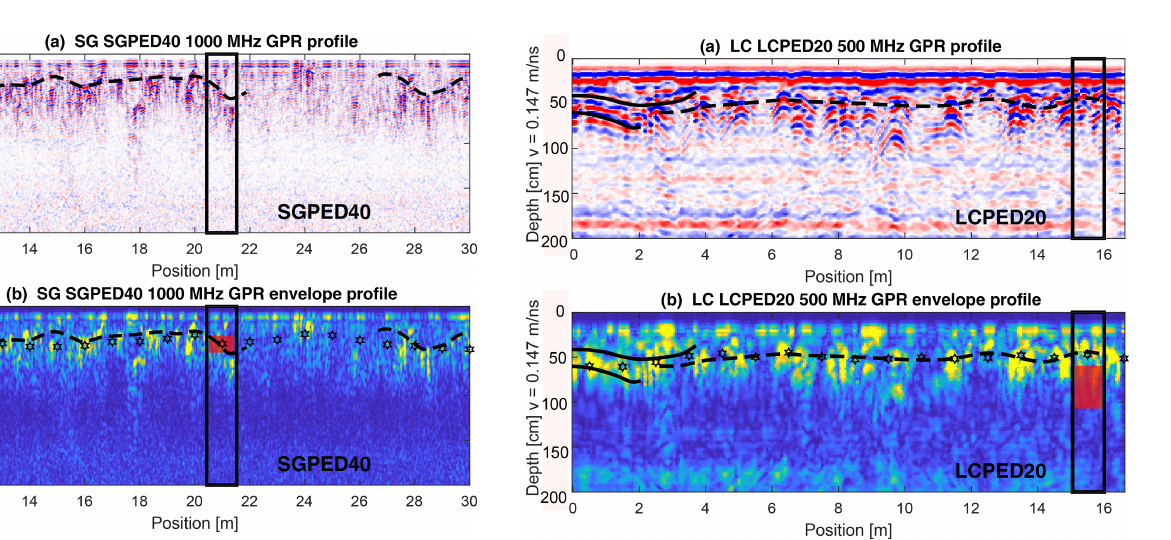
Figure 14. 500MHz GPR signal and envelope for the mid-slope position of the S-facing hillslope in La Campana (LCPED20). The hillslope transect spans over ∼ 8m. Interpretation of the radar signal is indicated where possible (stippled and black lines in a and b ). The potential pedolith thickness is indicated based on the envelope profile. Uphill is from left to right. Lines and symbols in figures as described in Fig.